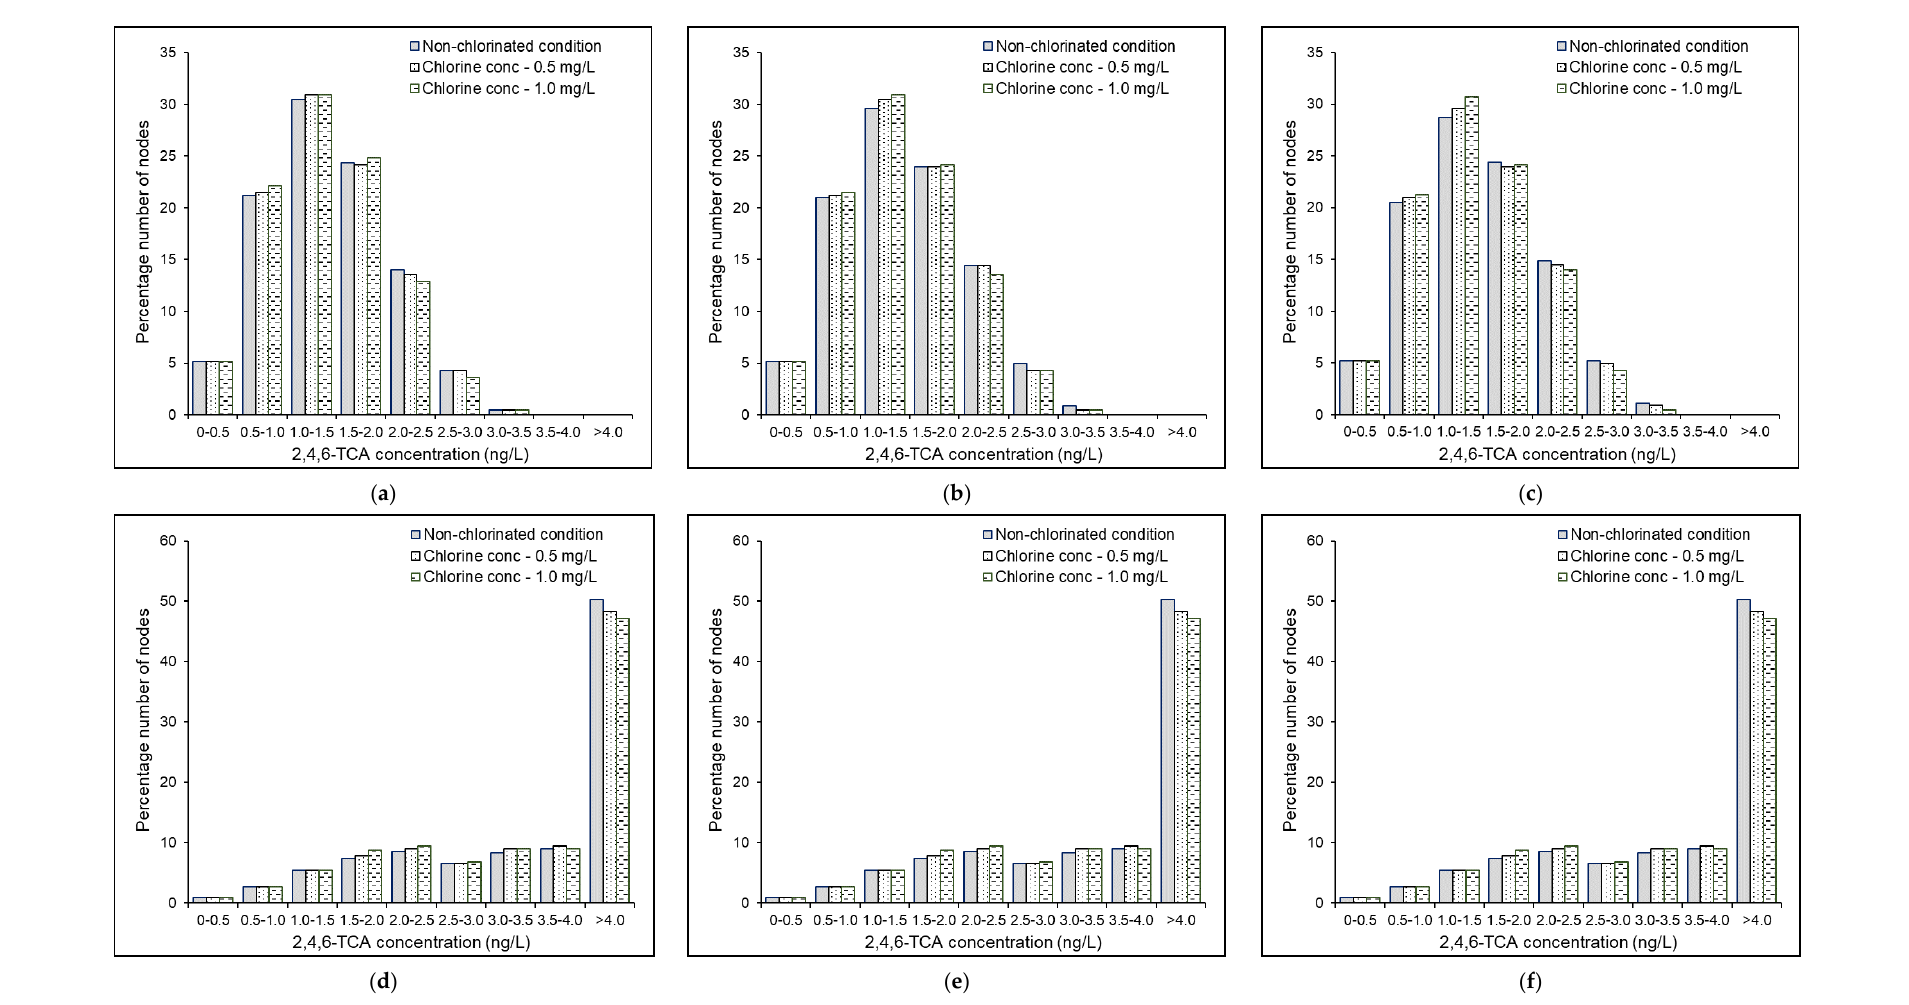
Figure 4. Predicted distribution of 2,4,6-TCA in the Balerma network under T = 25 ◦ C, P o = 0.2 mg/L, S o = ( a , d ) 0.01, ( b , e ) 0.1, and ( c , f ) 0.3 mg/L, and Scenarios ( a – ca; b; c; ) I and ( d – f )